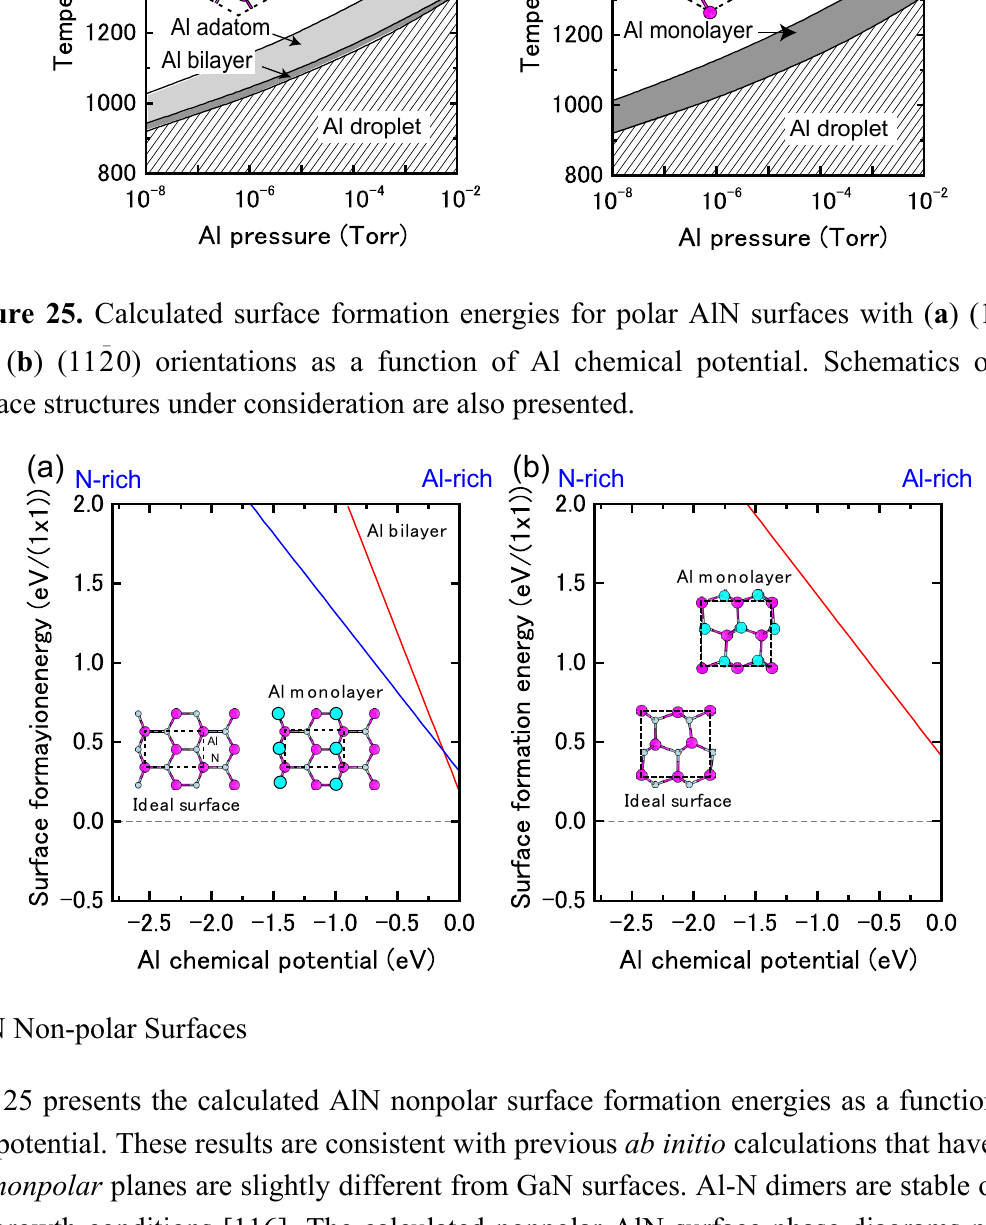
Figure 24. Calculated phase diagrams for polar AlN surfaces with ( a ) (0001) and _ ( b ) (0001 ) orientations as a function of temperature and Al BEP. The stable reconstructions on these surfaces are also schematically presented.